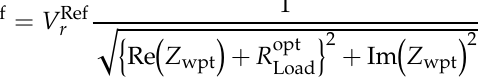
Table 6. Coefficients of Equation (24).